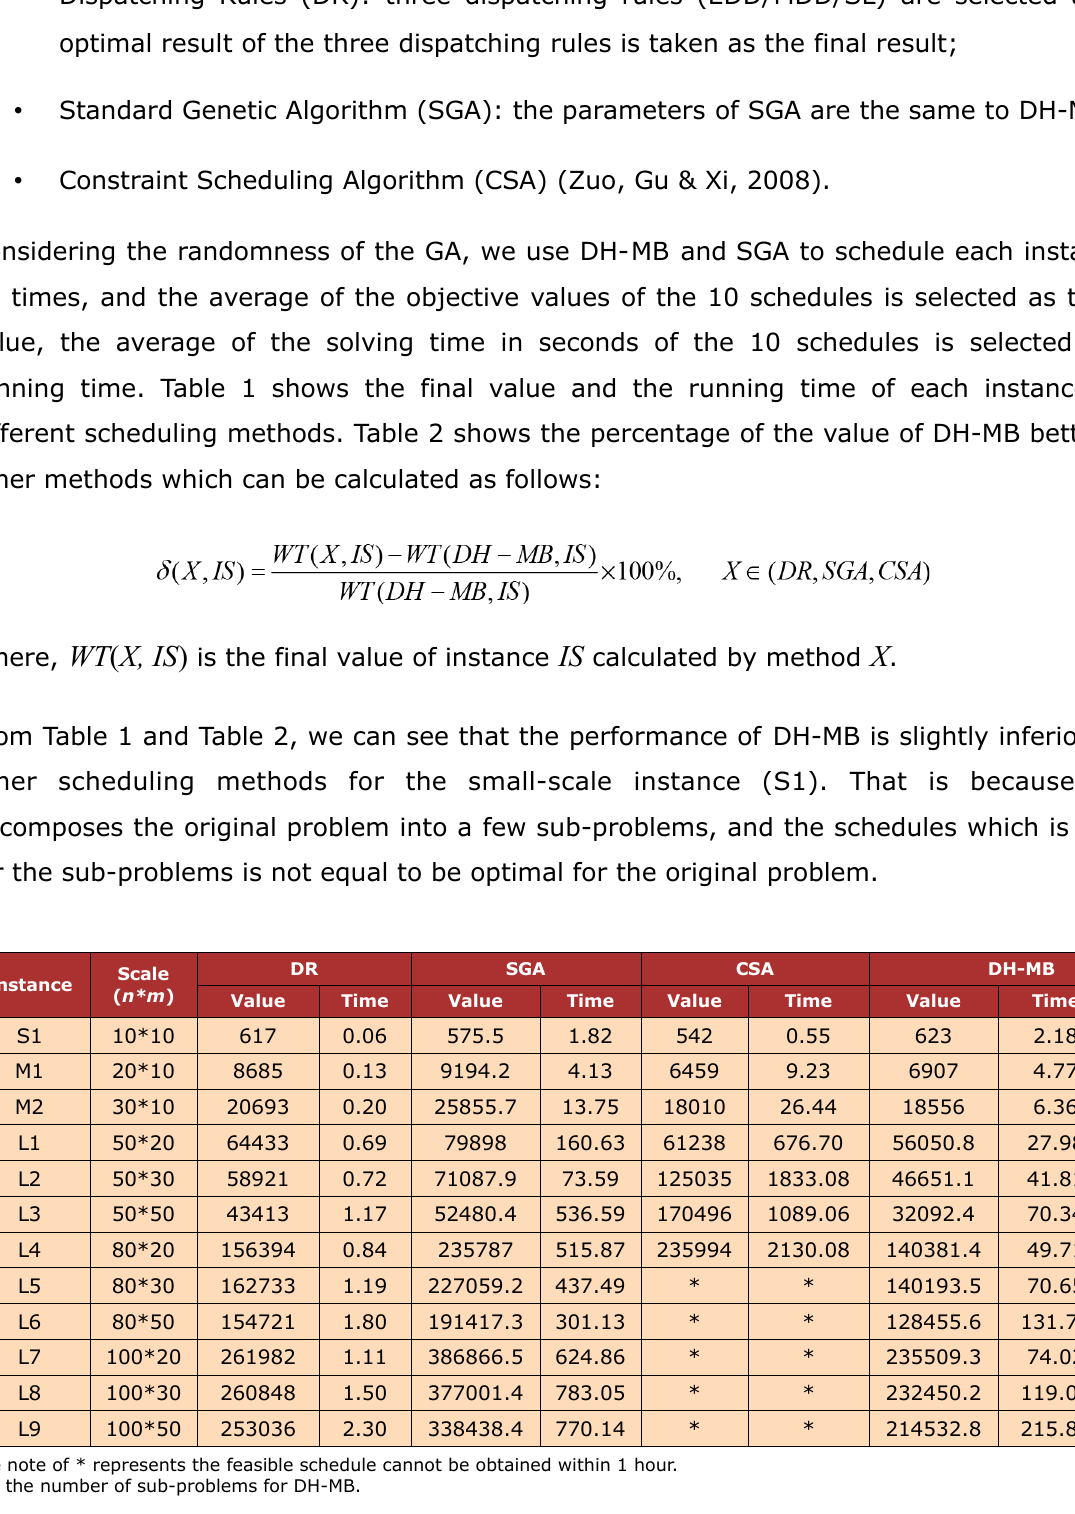
Table 1. The results of different scheduling